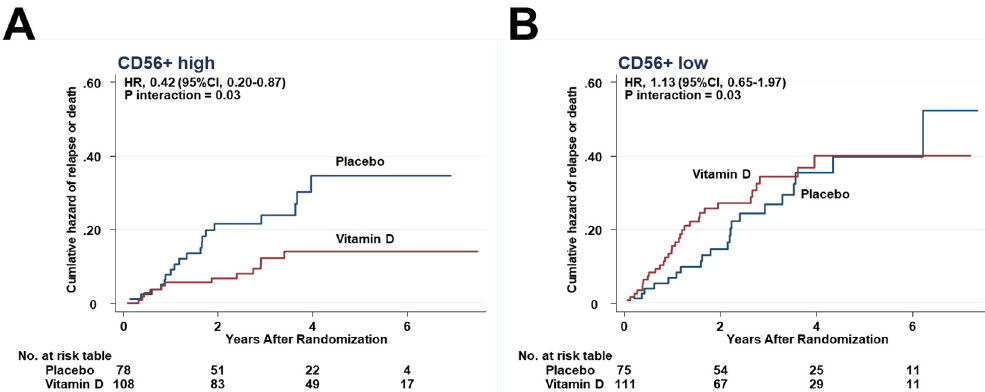
Figure 5. Effect of vitamin D on relapse or death in each subgroup. Nelson–Aalen cumulative hazard curves for relapse or death in the subgroups of ( A ) CD56+ higher half, and ( B ) CD56+ lower half.